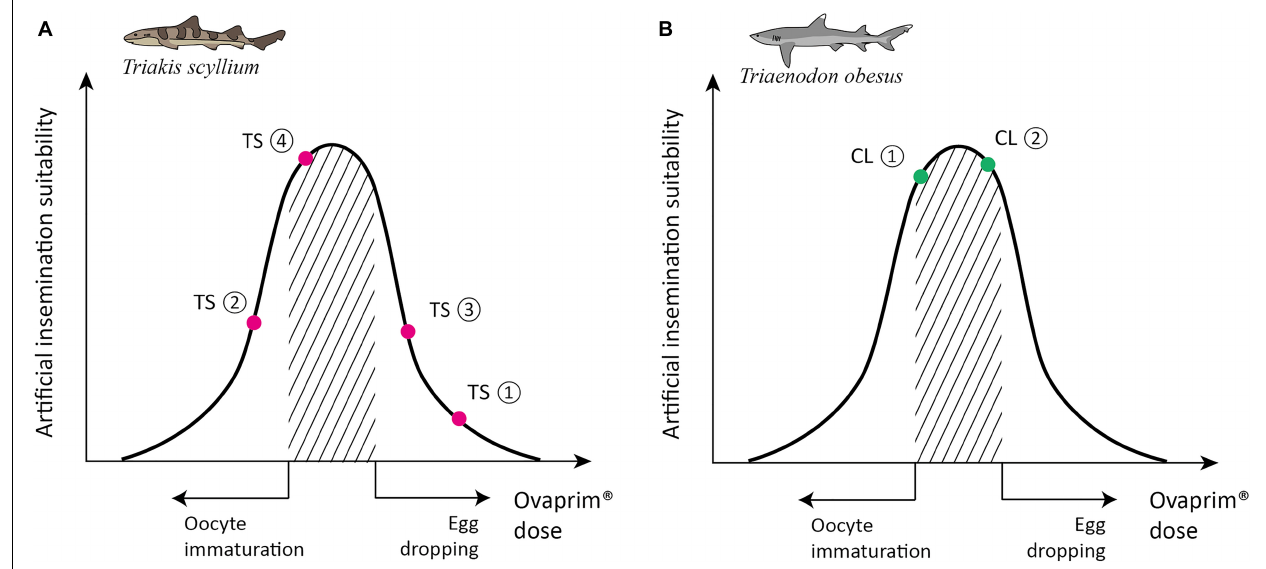
FIGURE 5 | Schematic graph of dose optimization in Triakis scyllium and Triaenodon obesus . A conceptual graph showing the correlation between biological phenomena (x-axis) and artificial insemination suitability ( y -axis) that change depending on the total dose of Ovaprim R (cid:13) administered. The shaded area denotes mature oocytes after follicle growth but prior to egg dropping, which is the targeted area for females in this study. (A) Ovaprim R (cid:13) experimental doses for female T. scyllium . TS (cid:172) : 0.6 mL/kg + 0.6 mL/kg, 6 h time gap; TS (cid:173) : 0.2 mL/kg + 0.4 mL/kg, 12 h time gap; TS (cid:174) : 0.2 mL/kg + 0.6 mL/kg, 24 h time gap; TS (cid:175) : 0.2 mL/kg + 0.5 mL/kg, 24 h time gap. (B) Ovaprim R (cid:13) experimental doses for female T. obesus . CL (cid:172) : 0.2 mL/kg + 0.2 mL/kg, 24 h time gap; CL (cid:173) : 0.2 mL/kg + 0.3 mL/kg, 24 h time